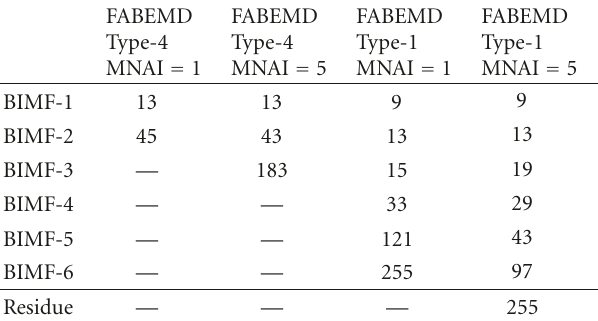
Table 6: Comparison among various FABEMD/BEMD for the STI in terms of order statistics filter width